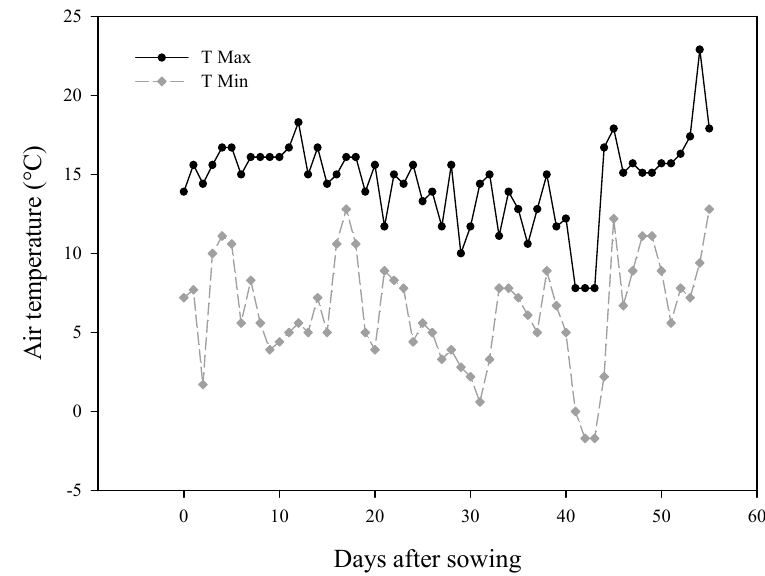
Figure 1. Trend of the maximum and minimum air temperature inside the plastic tunnel during the growing period of baby lettuce.